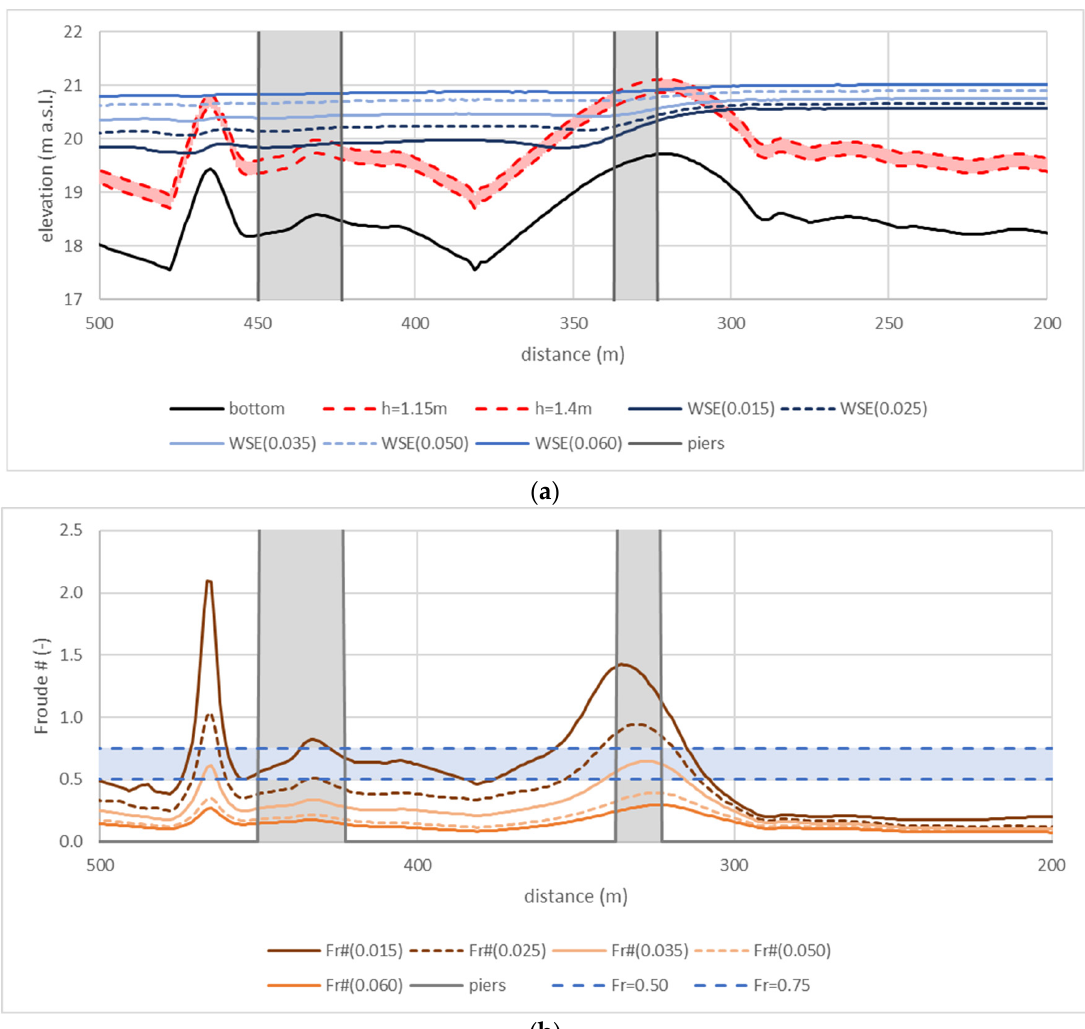
Figure 12. Examples of profiles under the bridge for discharge Q95%, ice: ( a ) water surface, ( b ) distribution of Froude #.